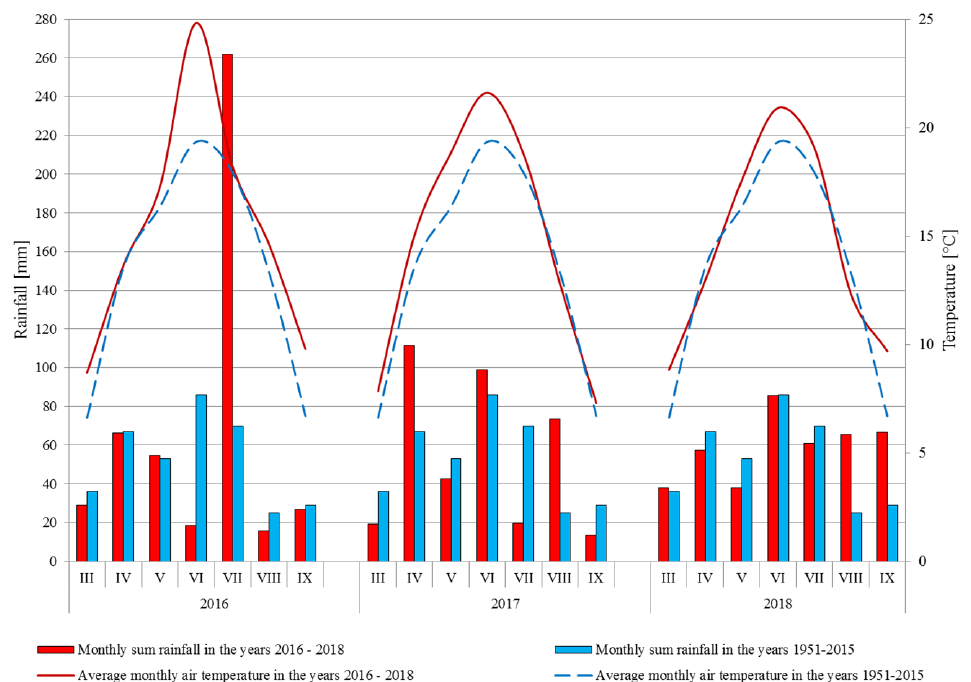
Figure 2. Comparison of precipitation and air temperature during the growing season of H. tuberosus in 2016–2018 according to data from the COBORU weather station in SDOO Uhnin.